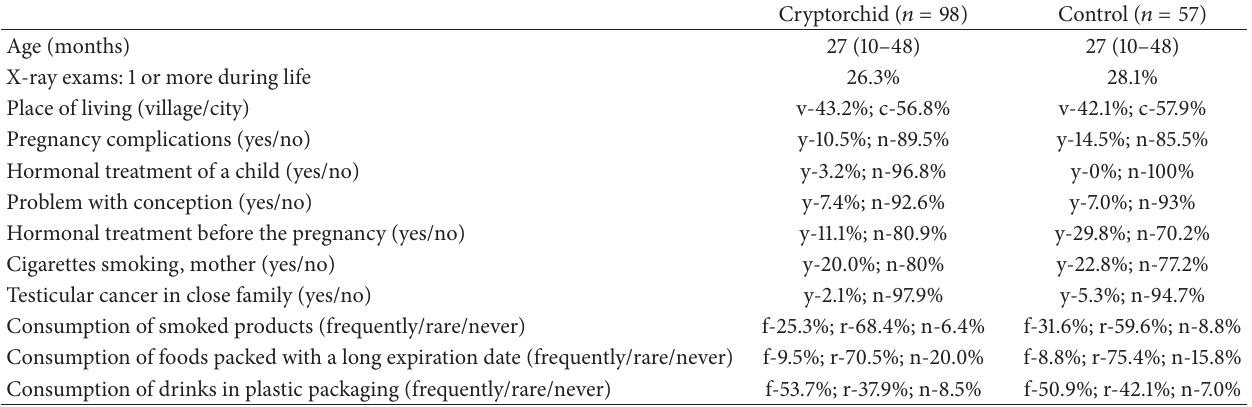
Table2:Parents’answerstoselectedquestionsfromtheriskofenvironmentalbisphenolexposurequestionnaire.Explanationofabbreviations used in the table is in the first column.